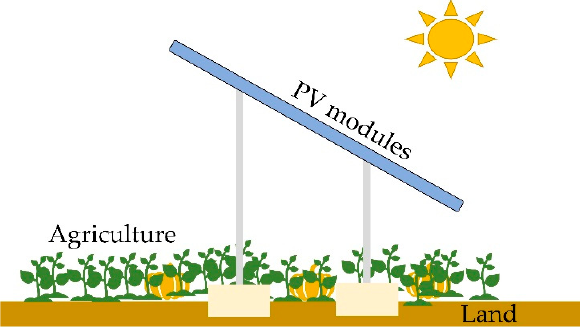
Figure 11. Conceptual representation of